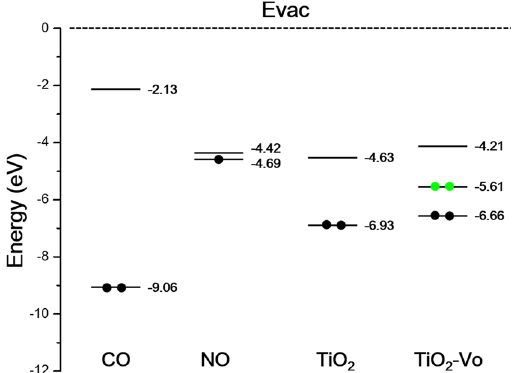
Figure 4. Calculated HOMO and LUMO of gas-phased CO and NO molecules, and band structures of the stoichiometric TiO 2 (110) surface and the reduced surface (TiO 2 -Vo) with respect to the vacuum energy level. Note that all the results are spin-degenerate expect for